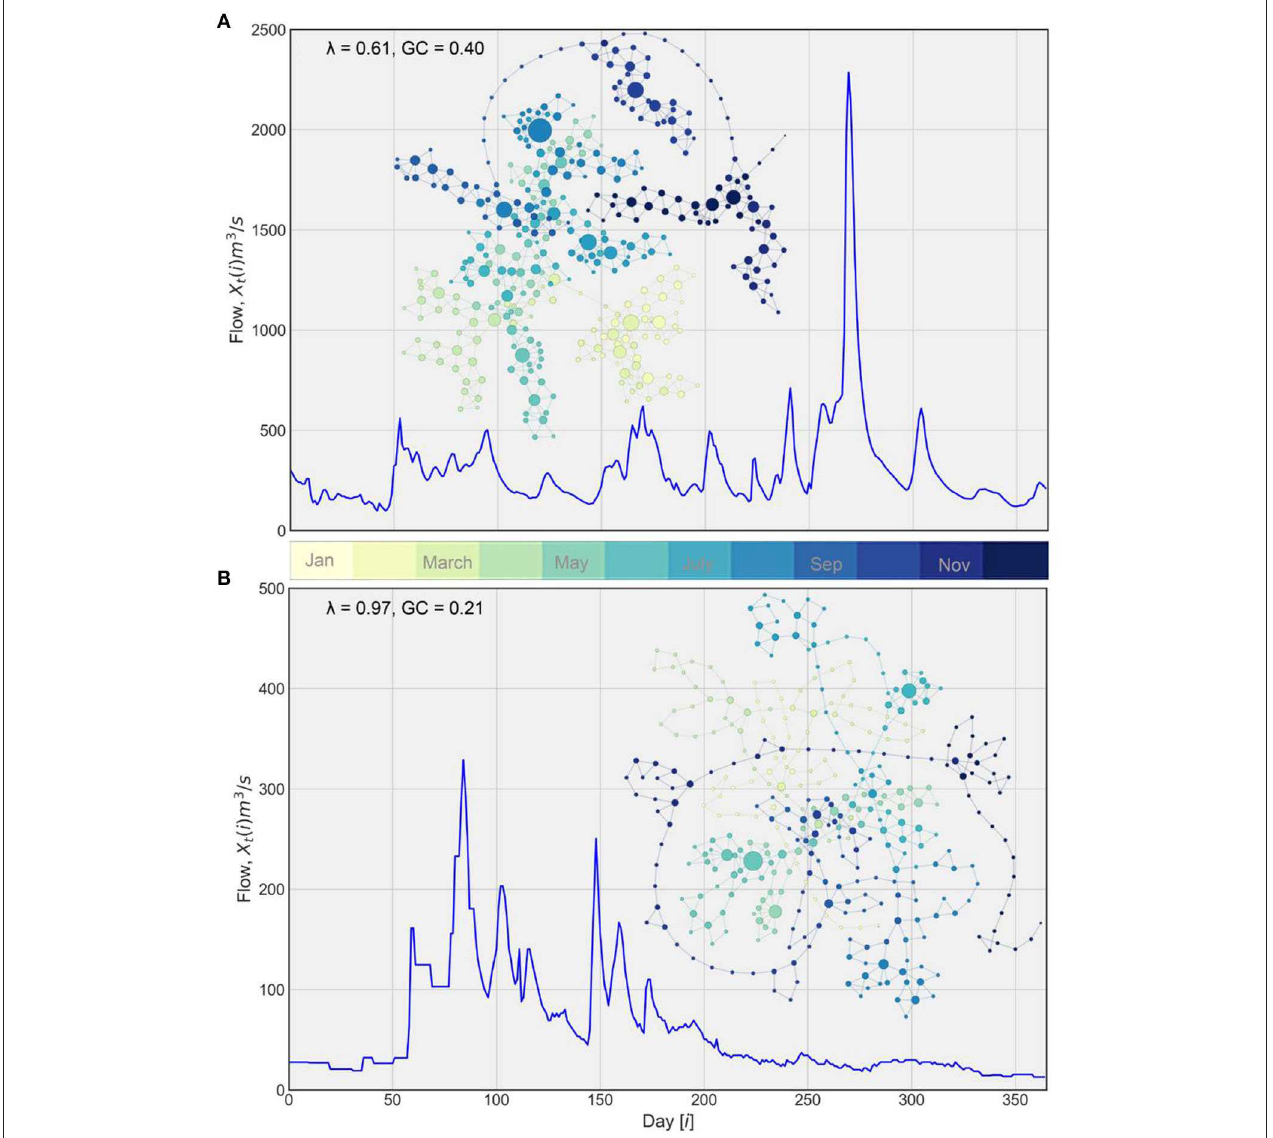
FIGURE 9 | Illustration of networks corresponding to natural streamflow time series for the Cedar River at Cedar Rapids station. The color code corresponds to the month of the time series while the size of nodes corresponds to the number of connections they have with other nodes. (A) Network for 2016. (B) Network for 1904.